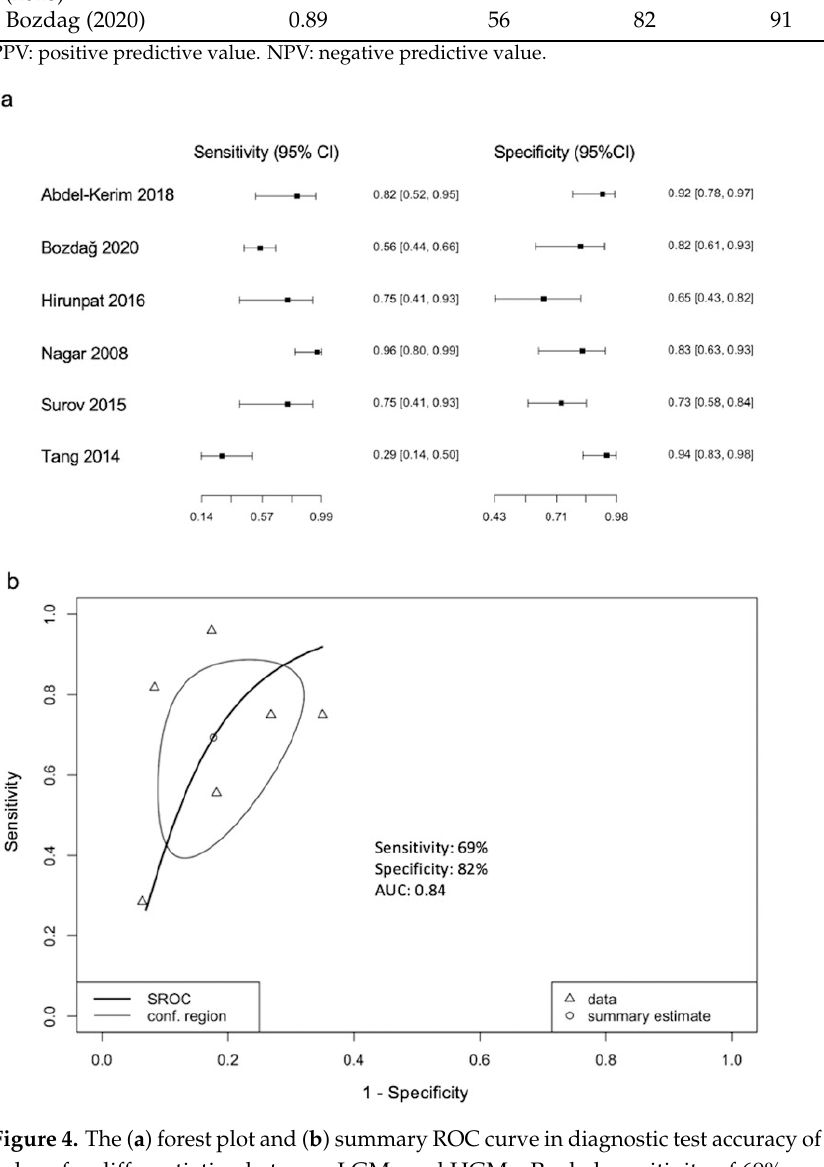
Table 3. Correlation coefficients ( r ) between mean ADC and Ki-67. Study